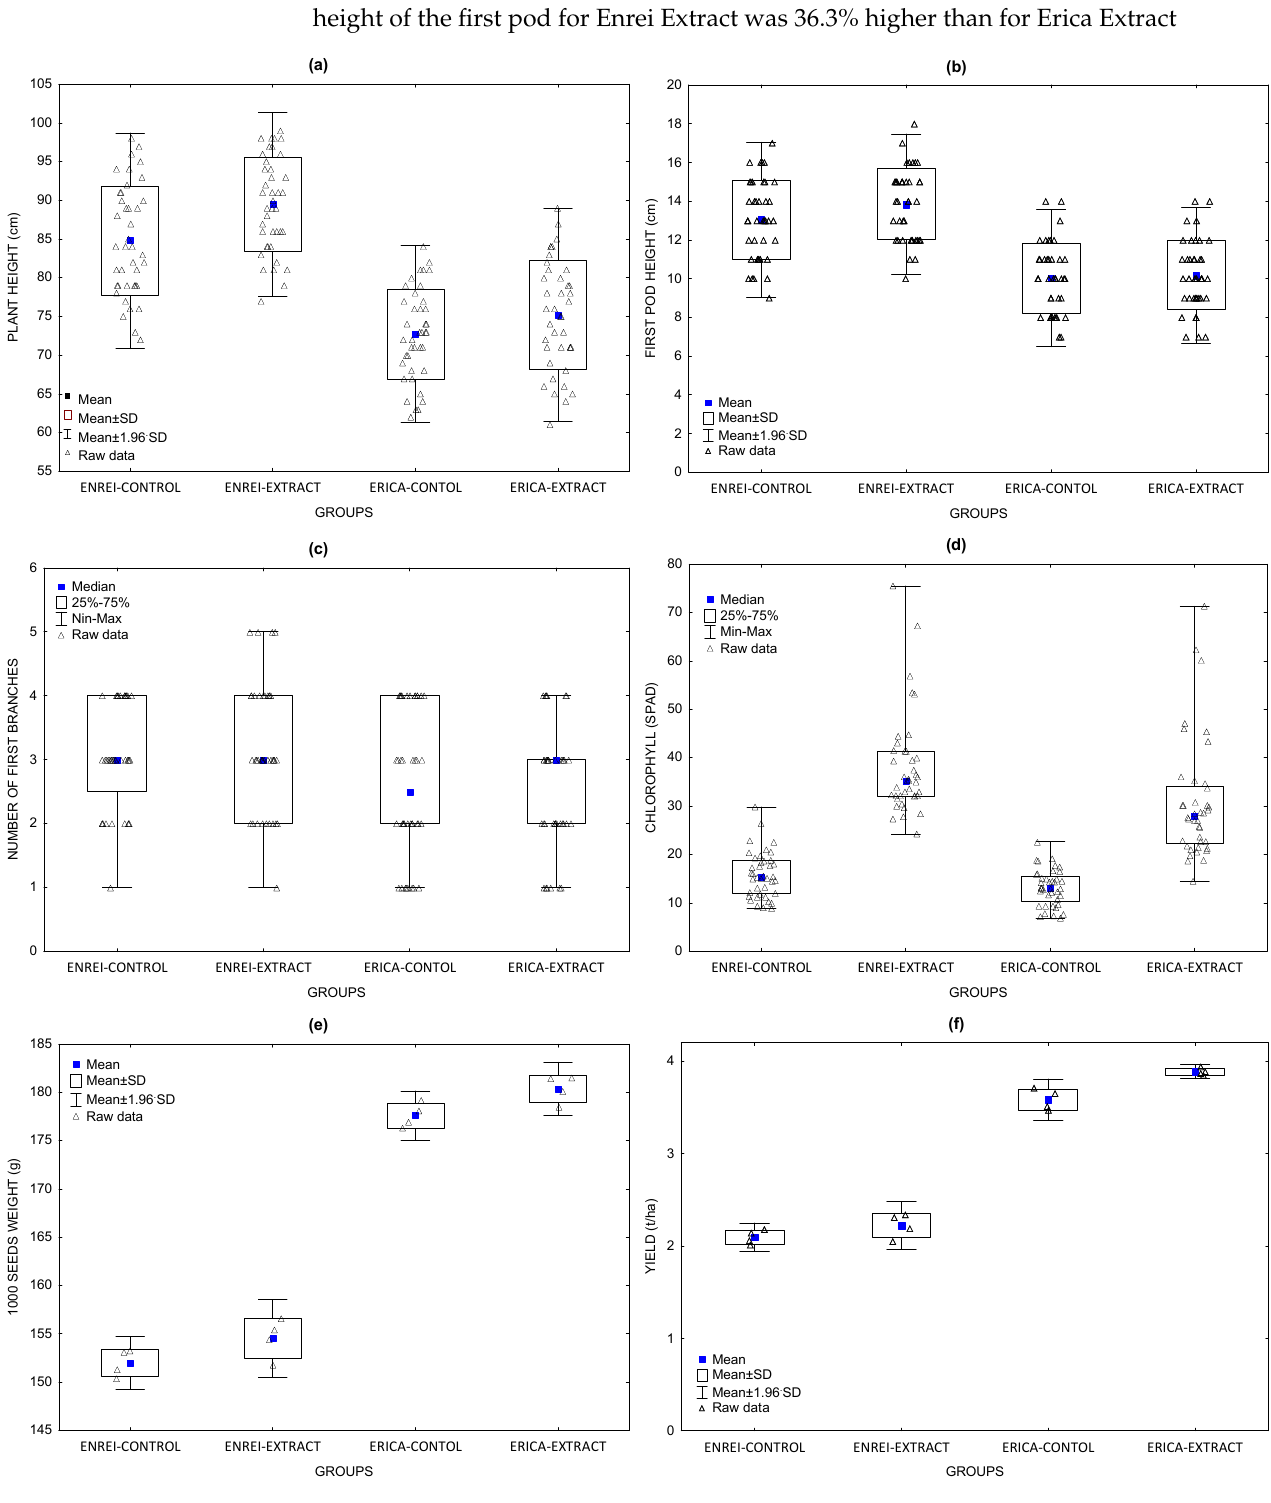
Figure 1. The effect of the algal extract on the ( a ) plant height (cm), ( b ) first pod height (cm), ( c ) number of first branches, ( d ) chlorophyll (SPAD), ( e ) 1000-seed weight (g), and ( f ) yield (t/ha) of two varieties of soybean (for data presented as the median, the Kruskal-Wallis non-parametric test was used to analyze the statistically significant differences; for data presented as the mean, the Tukey test was applied).